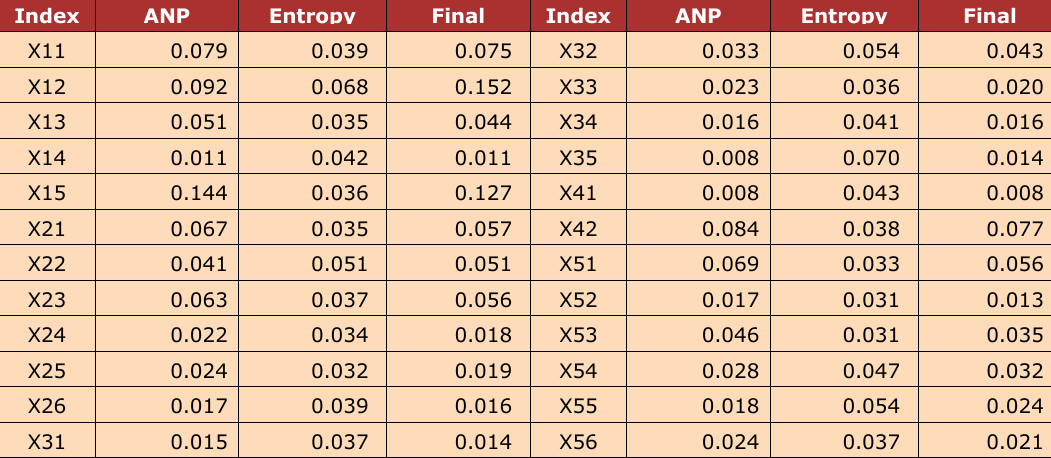
Table 3. Weights of evaluation